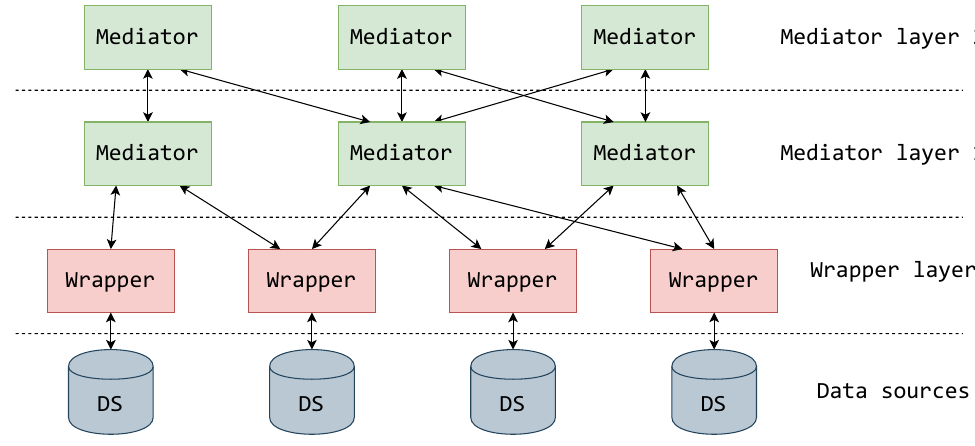
Figure 2. MW architecture with layered mediators